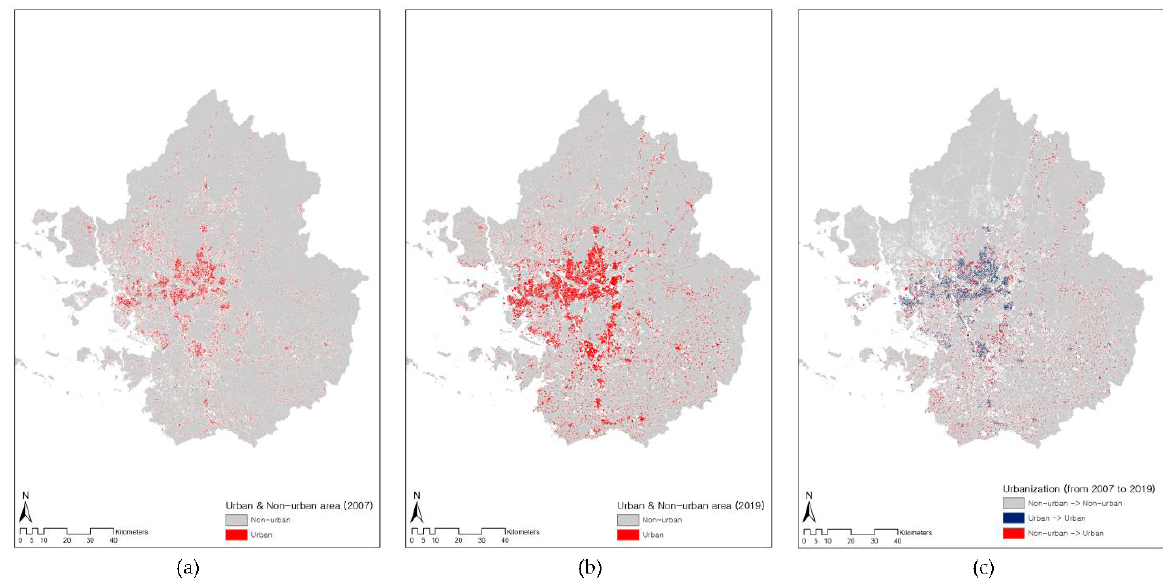
Figure 5. Spatial distribution of urban and non-urban areas in 2007 ( a ), 2019 ( b ) and urbanization from 2007 to 2019 ( c ).